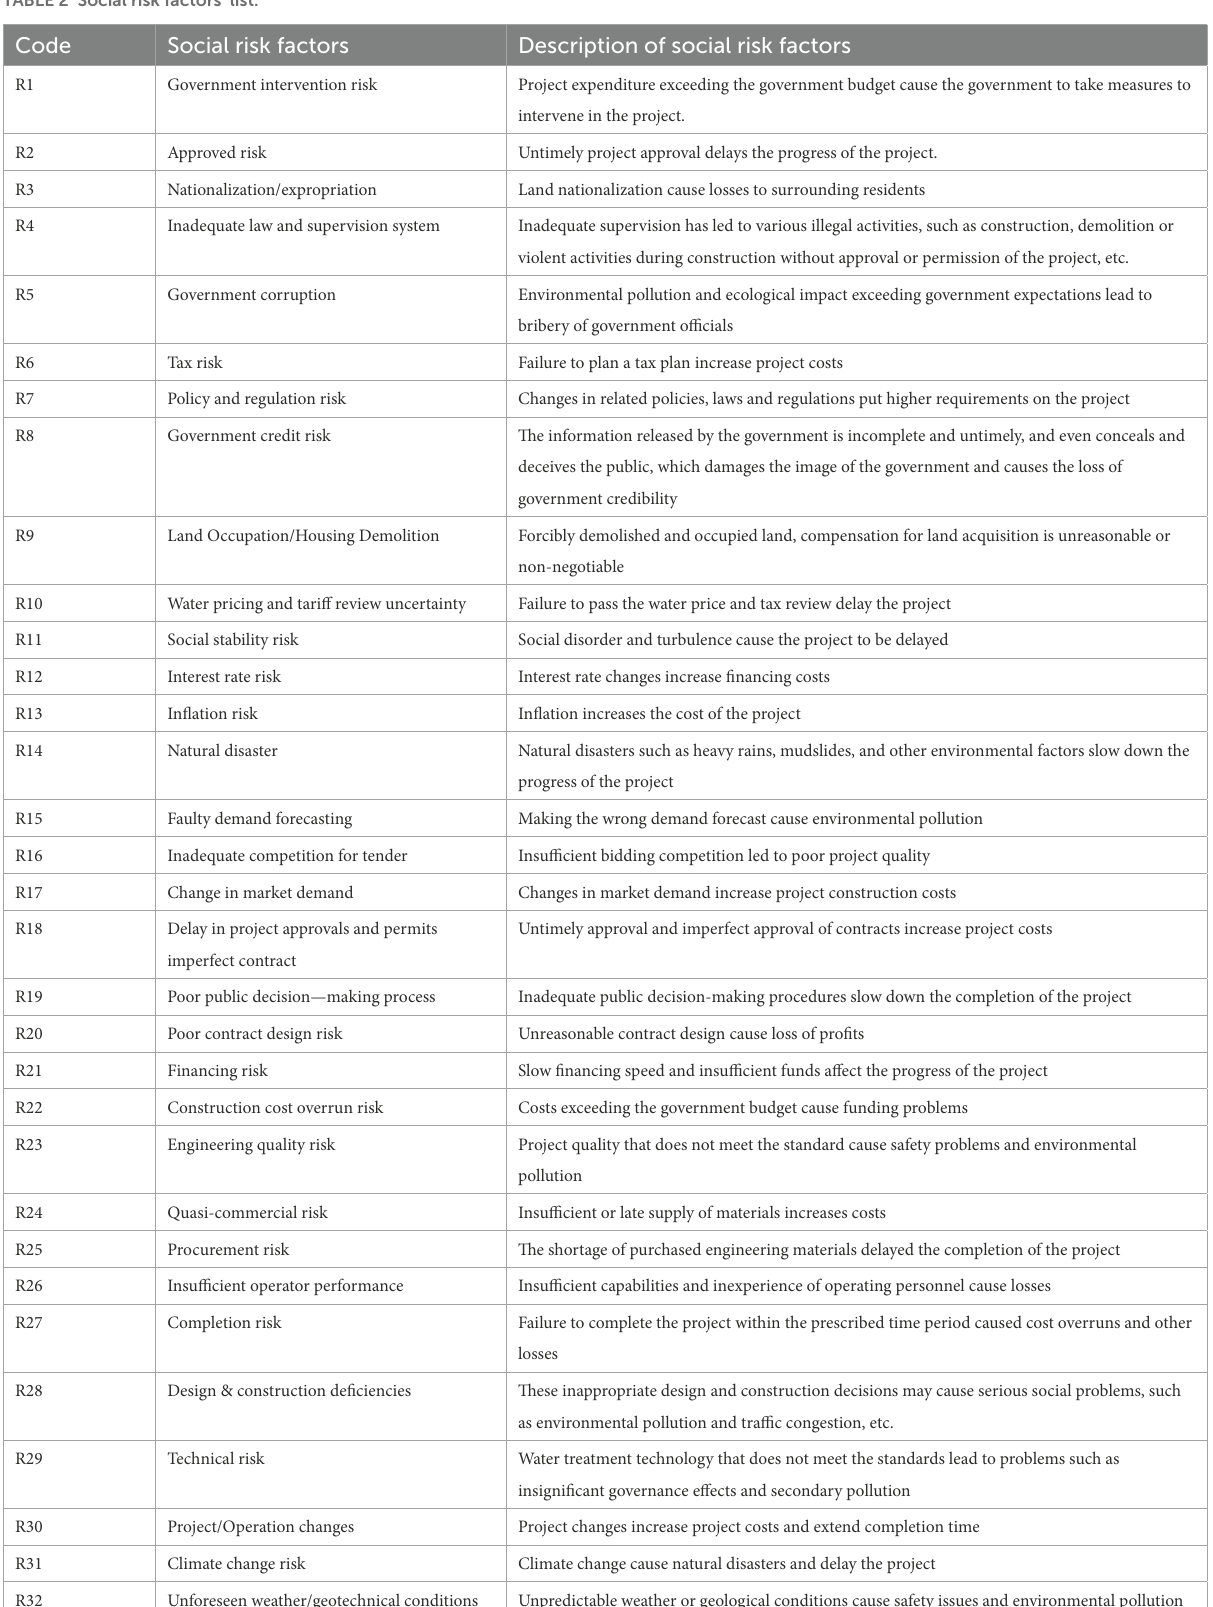
TABLE 2 Social risk factors’